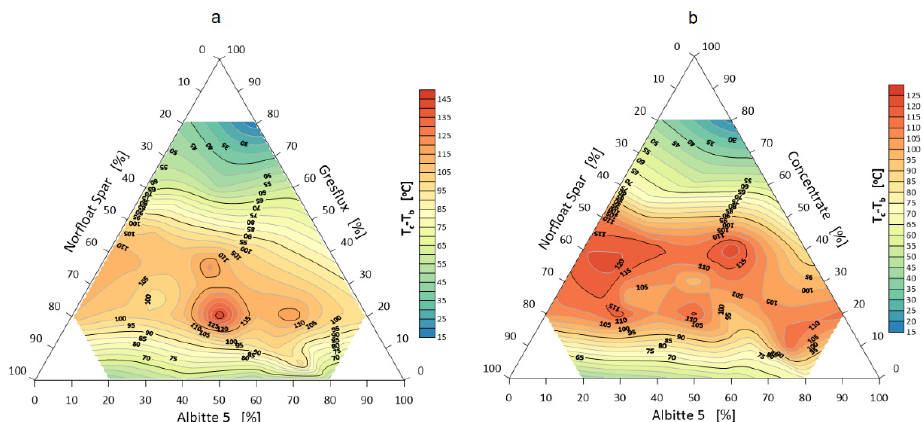
Figure 9. Melting interval of flux system Greflux–Albitte 5–Norfloat Spar ( a ), and Concentrate–Albitte 5–Norfloat Spar ( b ).